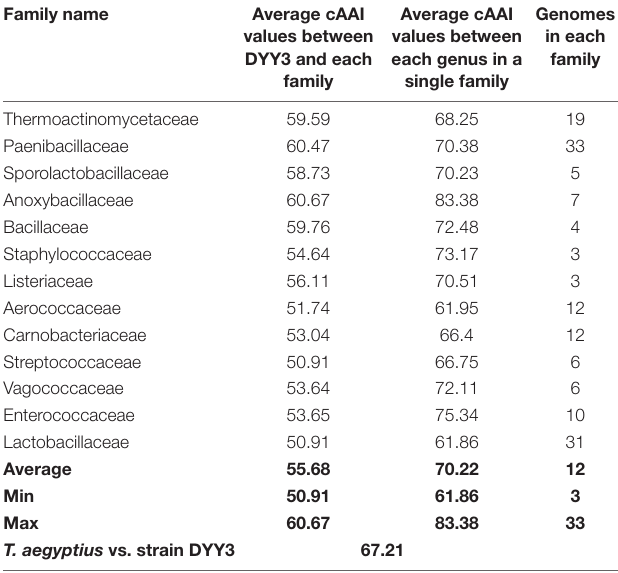
TABLE 4 | Statistical result of cAAI values between different families in Bacilli class.